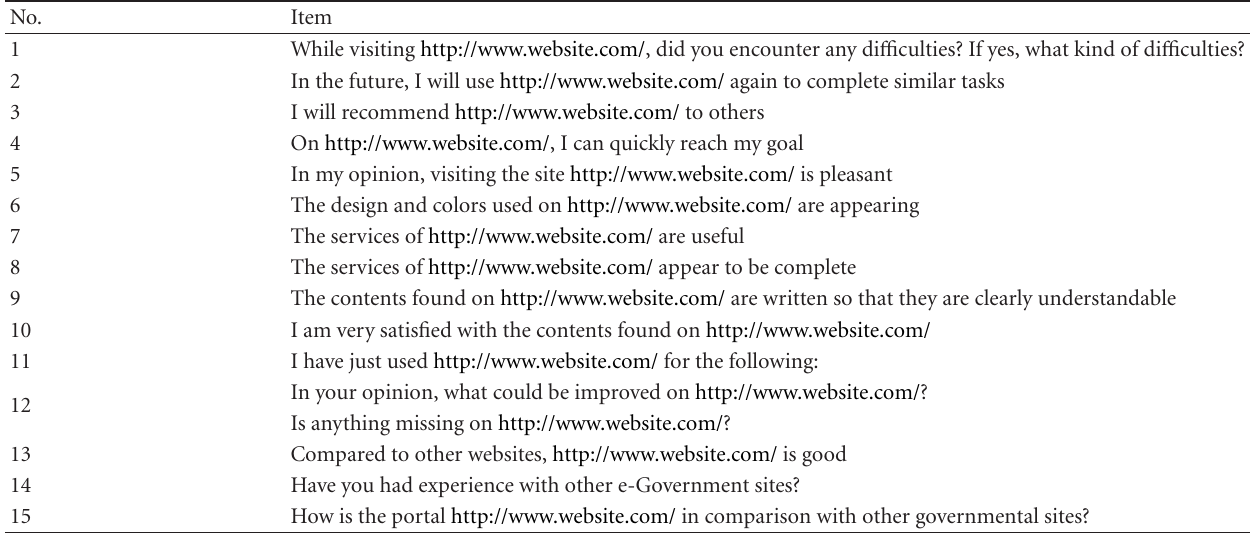
Table 1: First version of